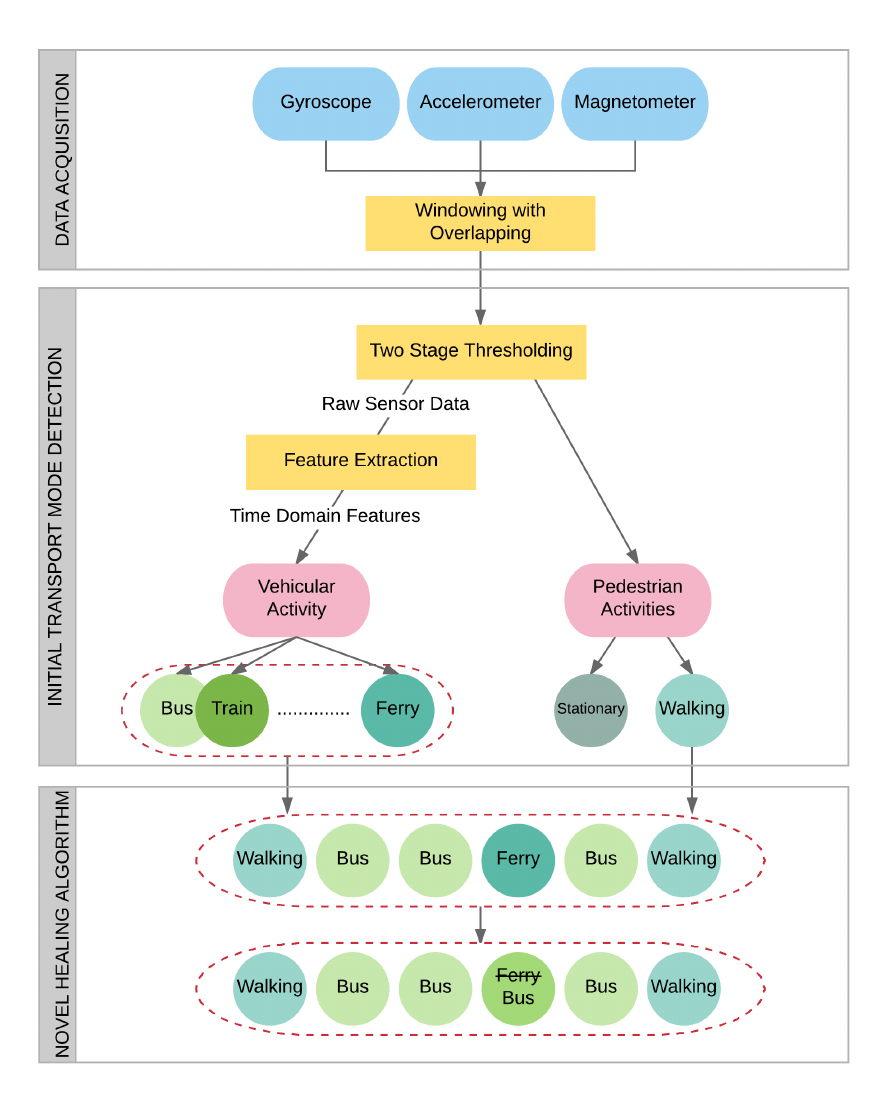
Figure 1. Multi-tiered architecture for transport mode